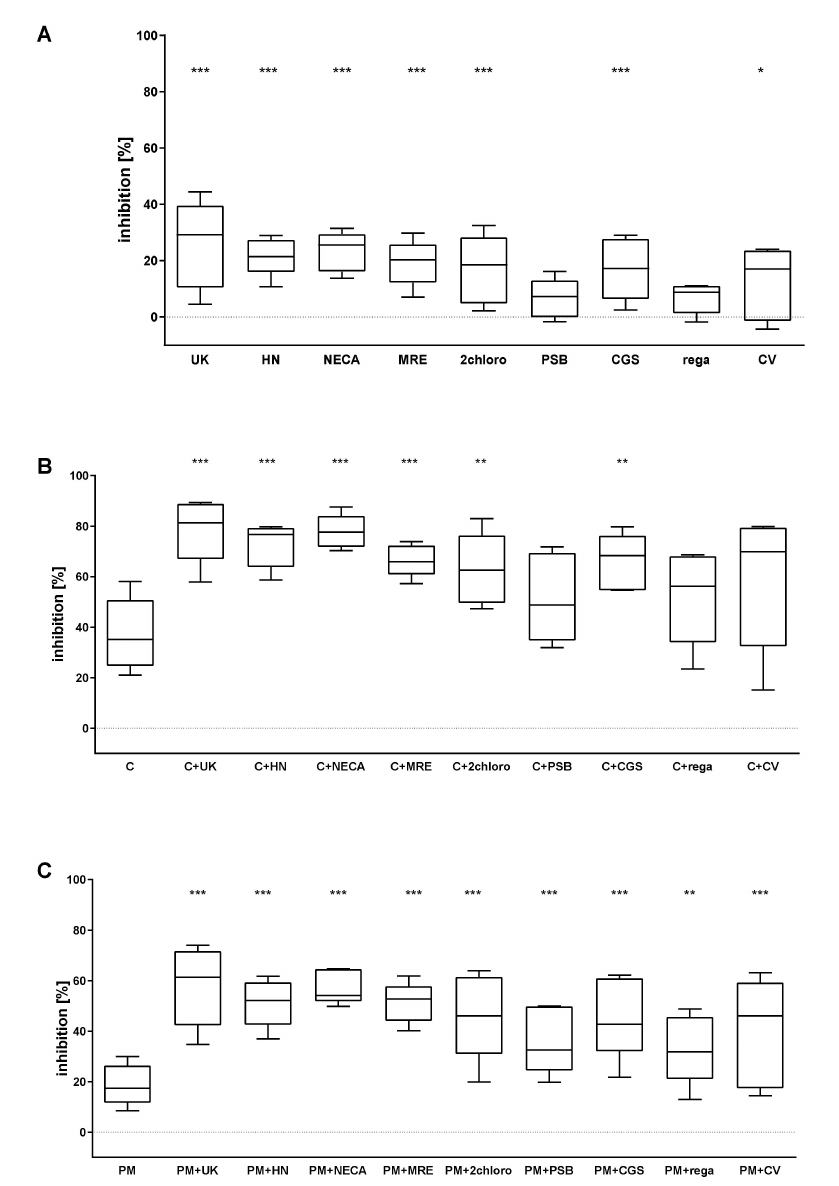
Figure 4. AR agonists intensify the inhibitory e ff ect of P2Y 12 antagonists on platelet reactivity as measured by exogenous fibrinogen binding ( n = 5). Panels present data on AR agonist impact on platelets ( A ), platelets antagonised with P2Y 12 inhibitor: cangrelor ( B ) or prasugrel metabolite (PM) ( C ). Data are shown as median, interquartile range (box), and minimum and maximum values (whiskers). Platelet reactivity was assessed after activation with 20 µ M ADP, in whole blood. Samples were preincubated at 37 ◦ C for 3 min with AR agonist and cangrelor or 15 min with PM, all in their previously determined IC 50 . Statistical significance estimated by one-way ANOVA for repeated measurements with the post hoc Bonferroni’s multiple comparisons test or Friedman’s test with Dunn’s correction for multiple comparisons (groups containing AR agonist are compared to control samples: untreated sample for AR agonists alone ( A ) or P2Y 12 inhibitor-treated samples for combined version ( B , C )). * p < 0.05, ** p < 0.01, *** p < 0.005. UK—UK423,097, HN—HE-NECA,